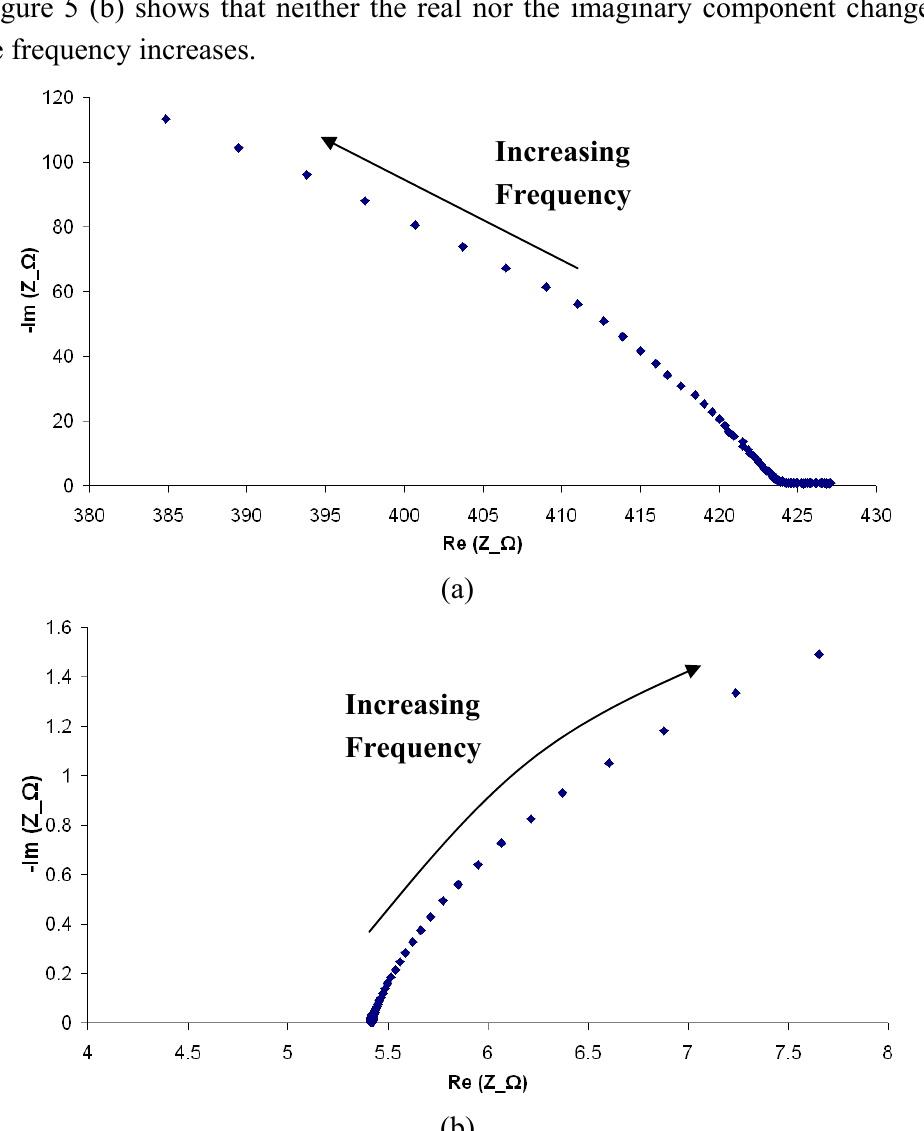
Figure 5. Impedance Spectroscopy of PANI/PVB/PS3 composite films fabricated using (a) Drop- Coating; and (b) Thick